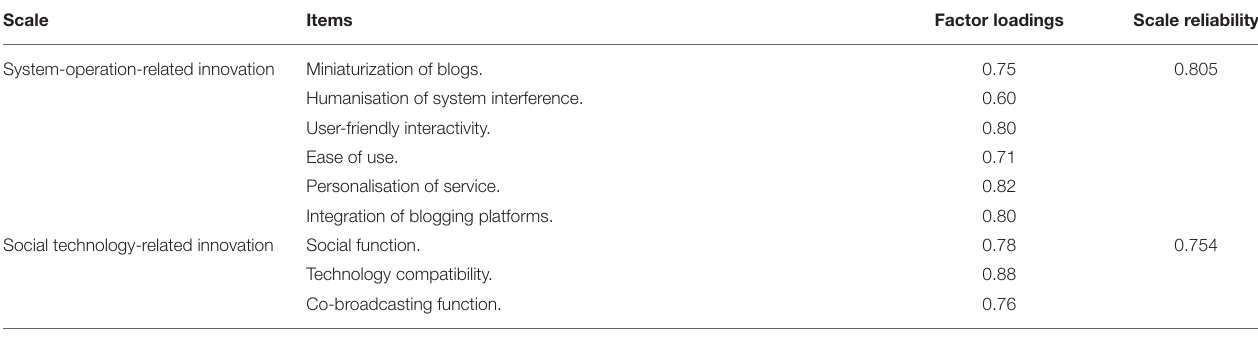
TABLE 3 | Pooled confirmatory factor analysis. Independent